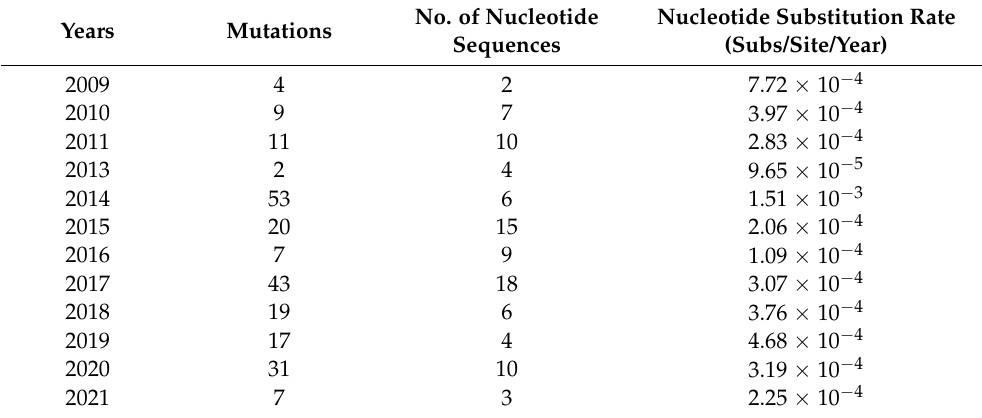
Table 3. Estimation of nucleotide substitution rates of P1 strains that were obtained and the changes in the consensus sequences with respect to the 2005 submissions’ sequences. No. of Nucleotide Years Mutations